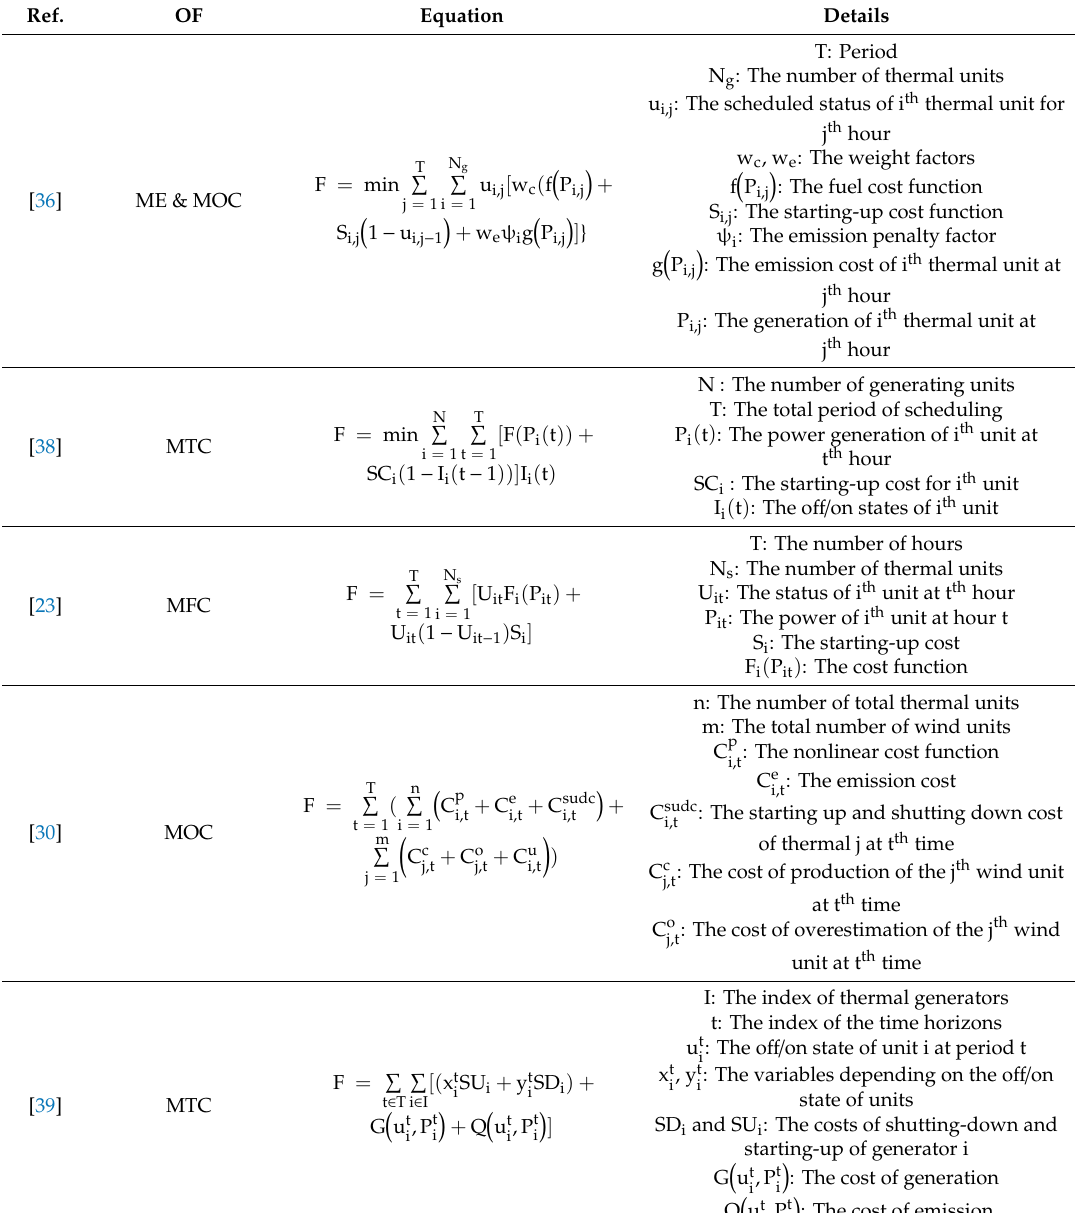
Table 2. Objective functions for the studies that utilize extended particle swarm optimization.